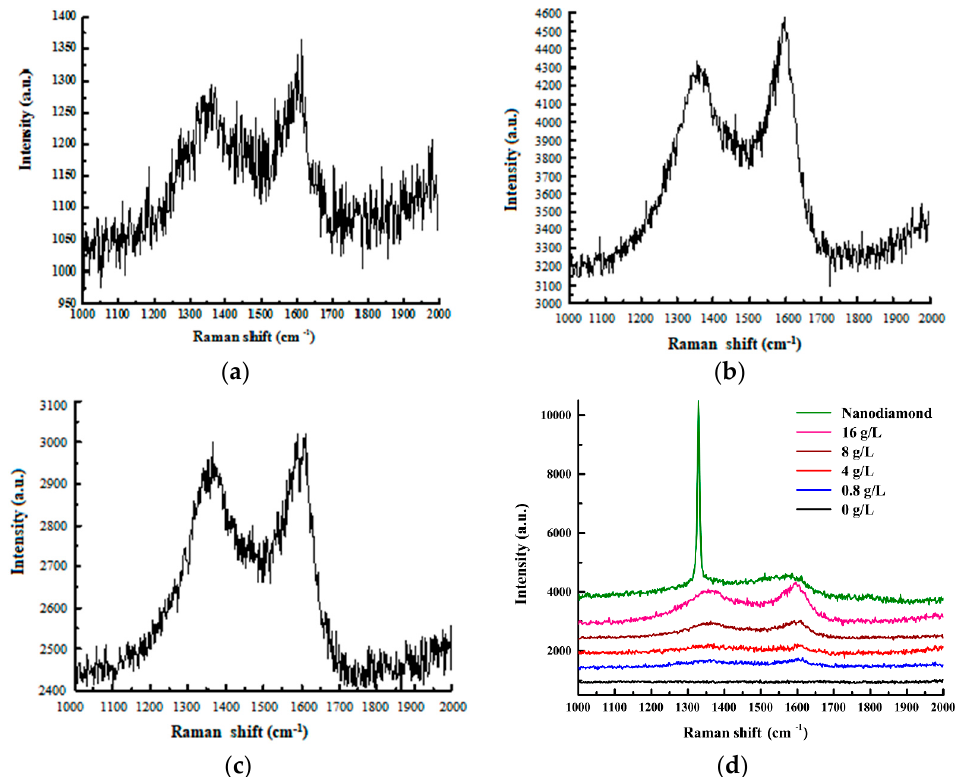
Figure 4. The Raman spectra of the composite coating deposited at various concentrations of nanodiamond particles in the plating solution from 0 to 16.0 g/L: ( a ) 4 g/L, ( b ) 8 g/L, ( c ) 16 g/L, and ( d ) a multiple comparison study.